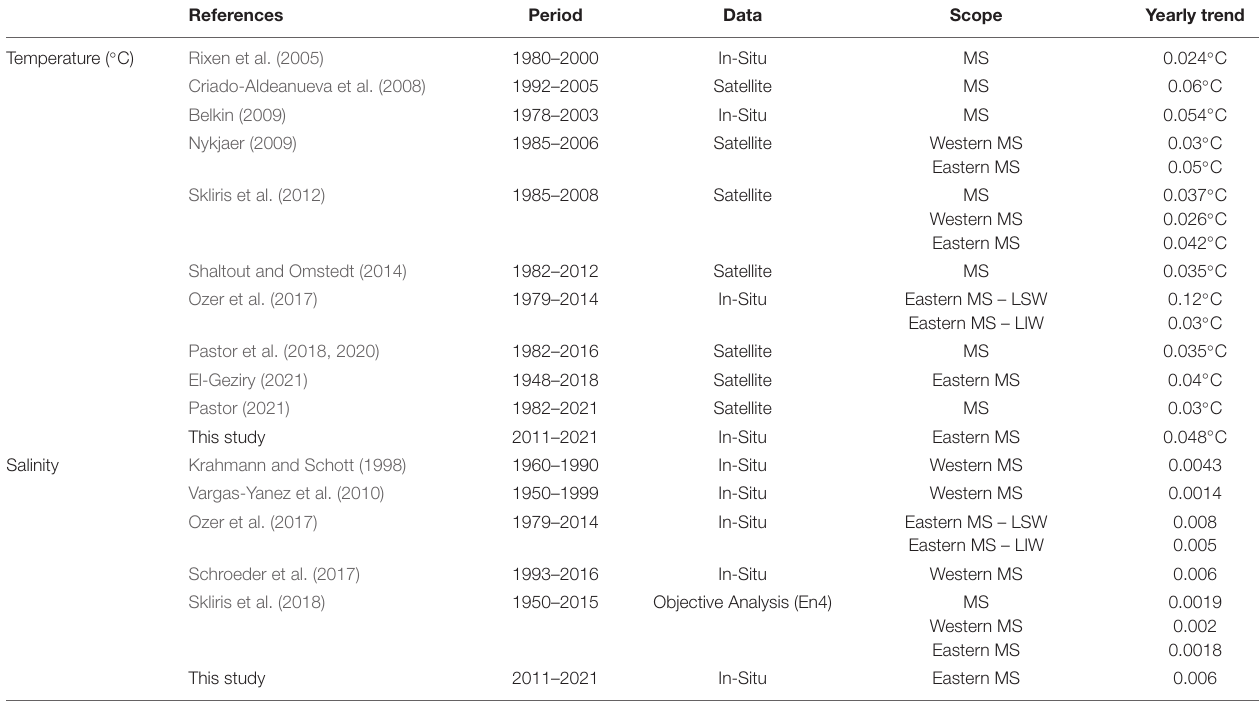
TABLE 1 | Reported temperature and salinity yearly trends from investigations in various areas of the Mediterranean Sea, based on different data sources and time